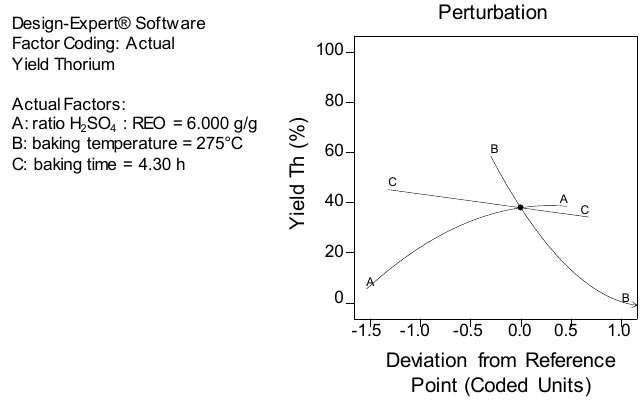
Figure 13. Perturbation plot for the response “Yield Th.”